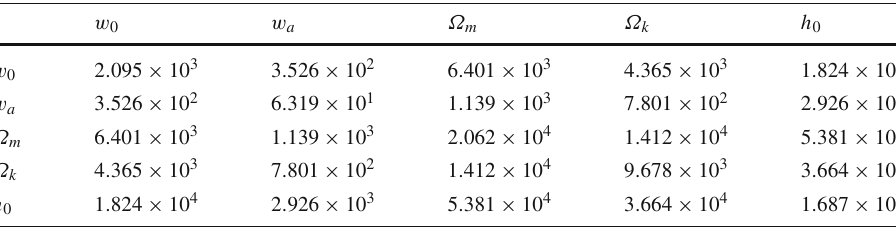
Table 6 The ET GW Fisher matrix for the nonuniform distribution of GW